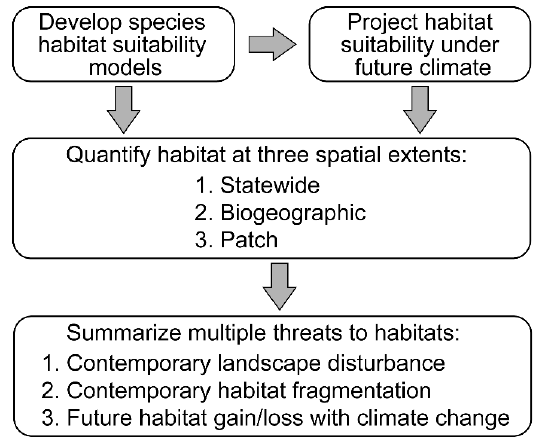
Figure 2. Flow chart of study methods.